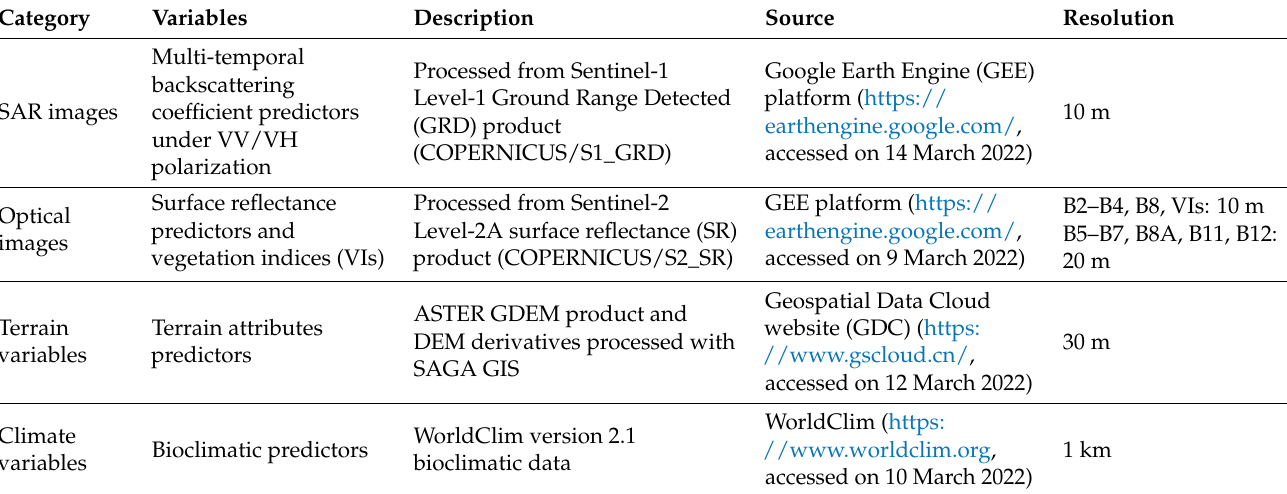
Table 1. Environmental variables used in this study.